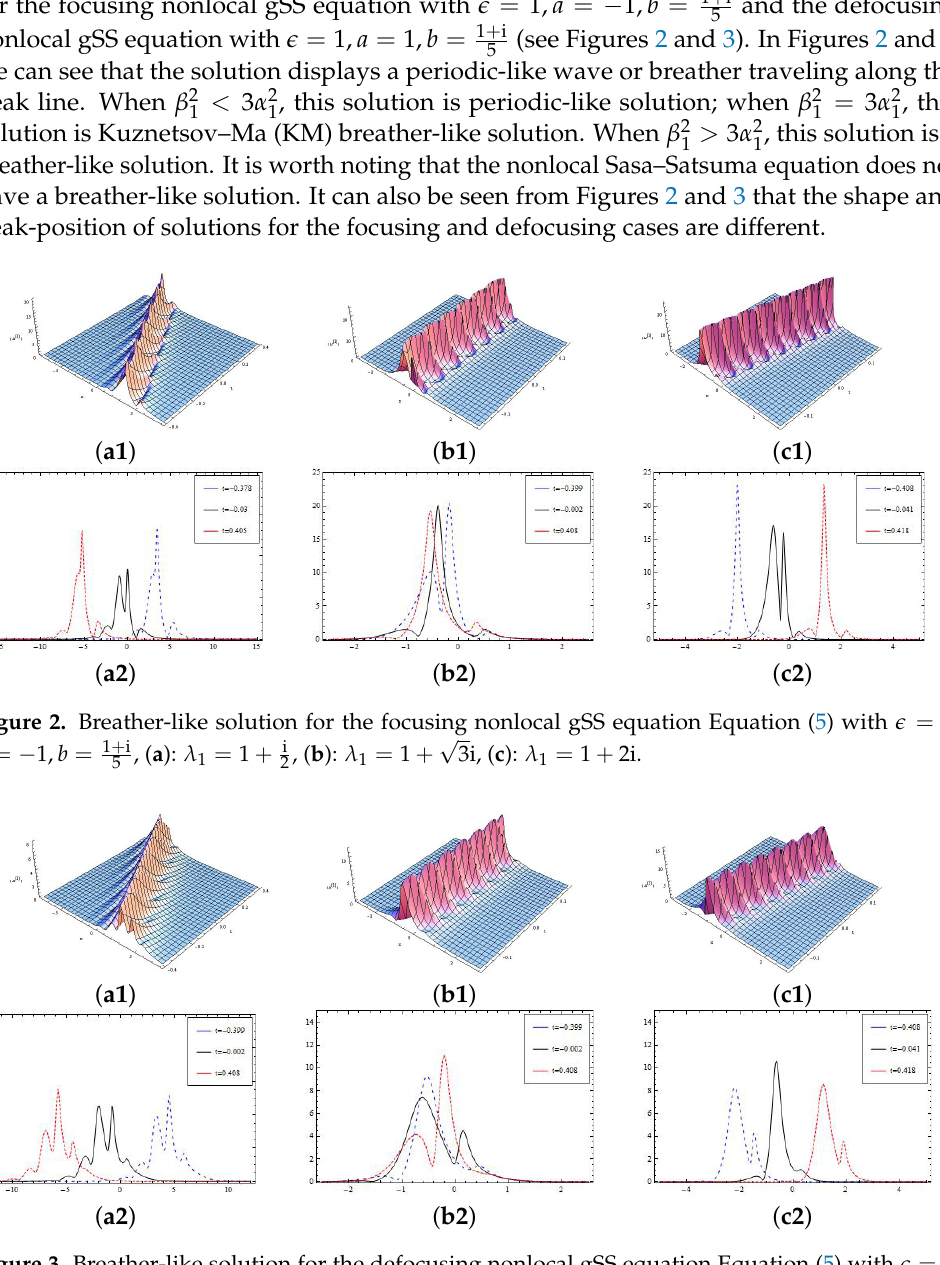
Figure 3. Breather-like solution for the defocusing nonlocal gSS equation Equation (5) with (cid:101) =